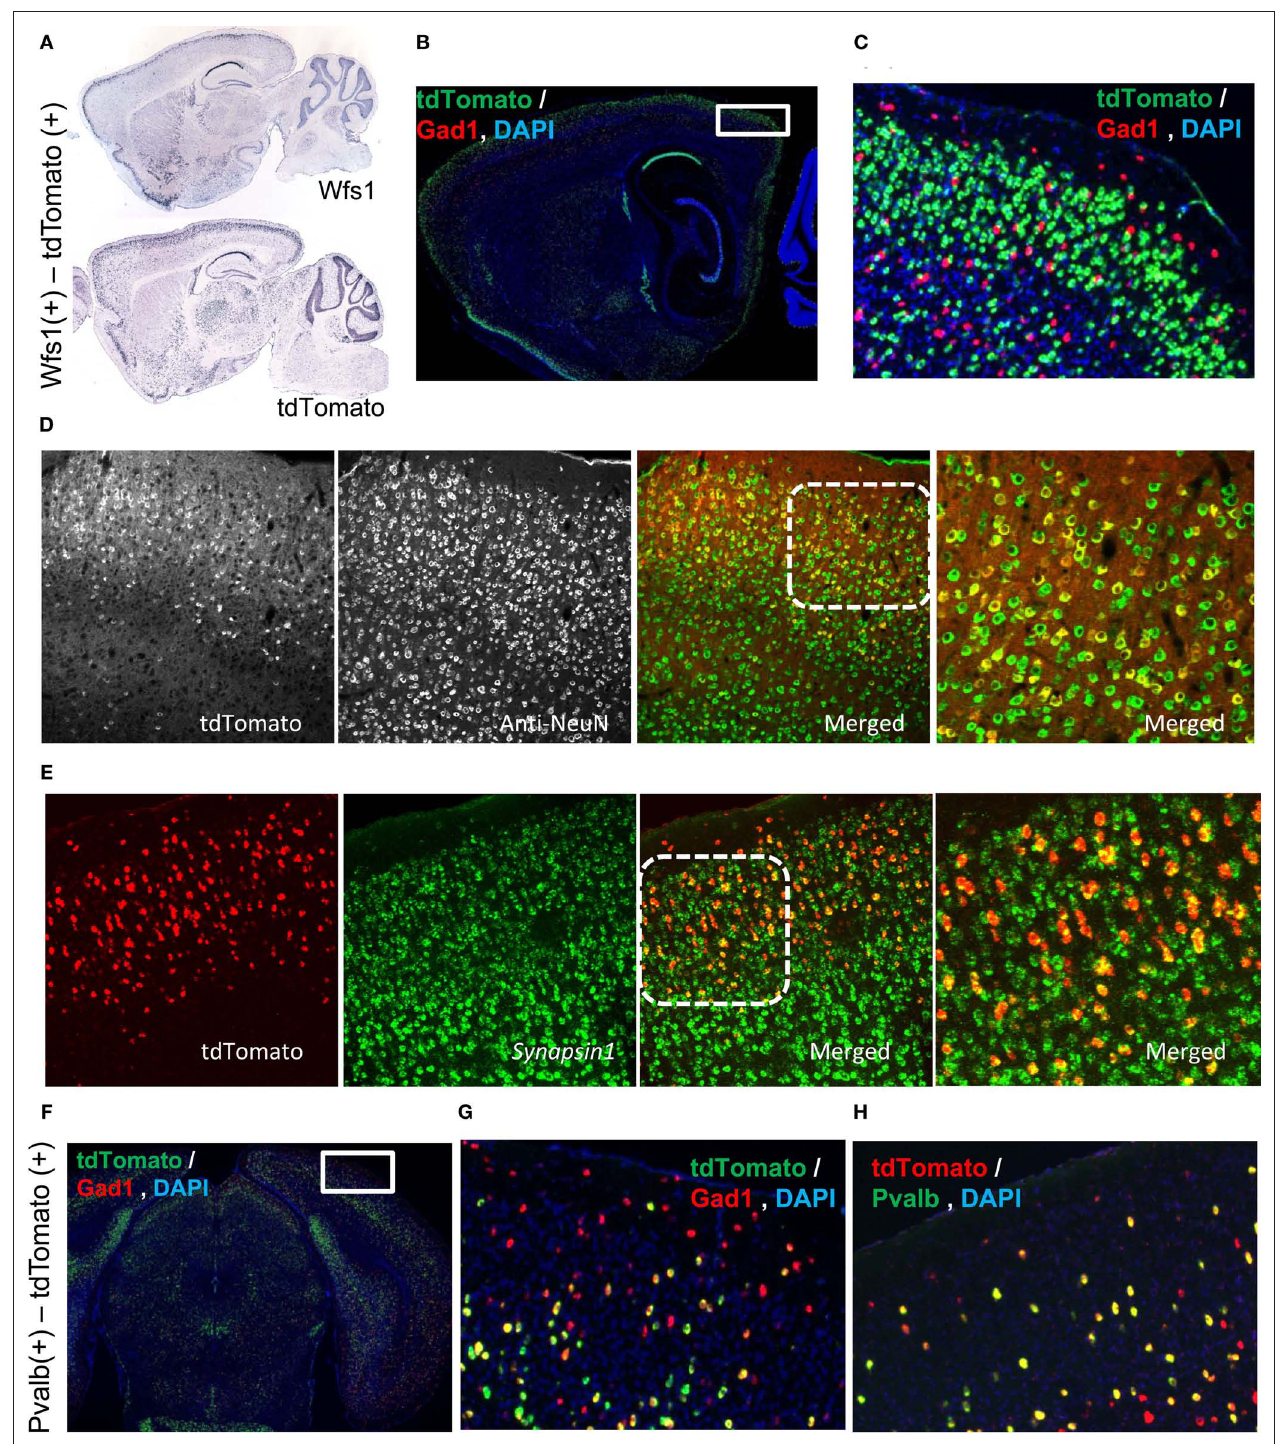
secondary) in a Wfs1 (+) mouse crossed with Ai9 reporter mouse. (e) dFISH characterization with probes for Synapsin I and tdTomato genes in Wfs1 ( + ) – Ai9 mouse. Superficial layer on the top in both (D,e) . Area marked with dotted square on the merged image in (D,e) is shown enlarged in the subsequent image to the right. (F,G,H) Pvalb ( + ) cell population in superficial layers is Gad1 ( + ). dFISH shows Gad1 (red) and tdTomato (green) expression pattern (F,G) , and tdTomato (red), Pvalb (green) expression (H) . The area boxed in (F) is enlarged in (G)